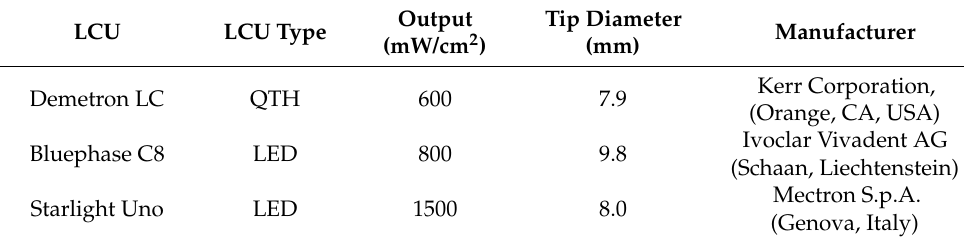
Table 2. Characteristics of the employed